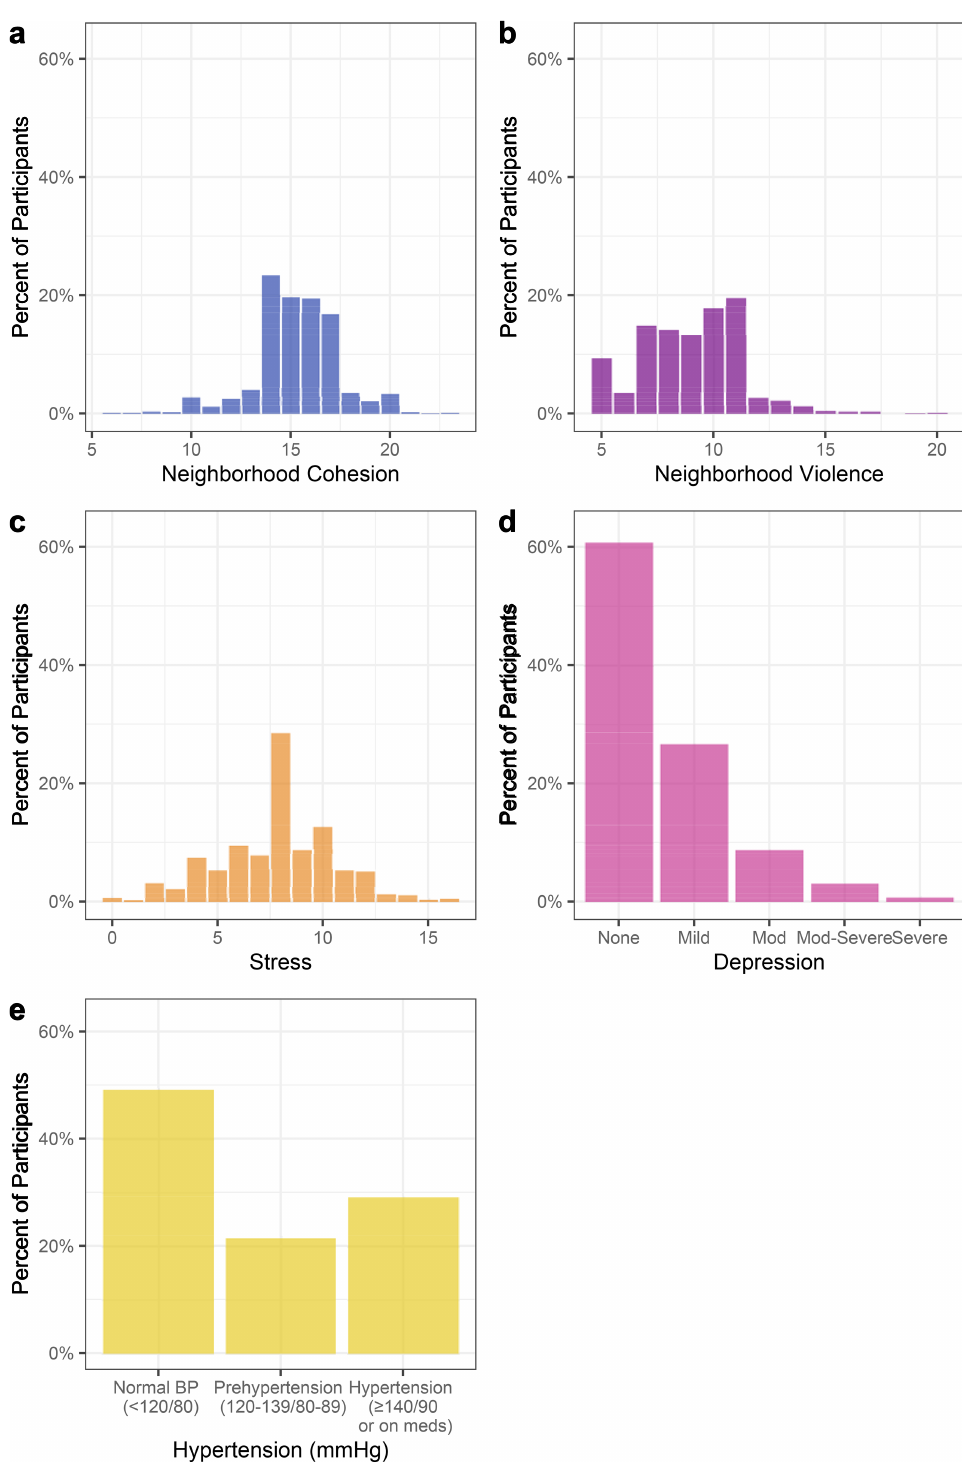
Fig 2. Distribution of neighborhood cohesion, neighborhood violence, perceived stress, depression, and hypertension. X axis represents the scores, or blood pressure categories. Y axis represents the percent of participants with that